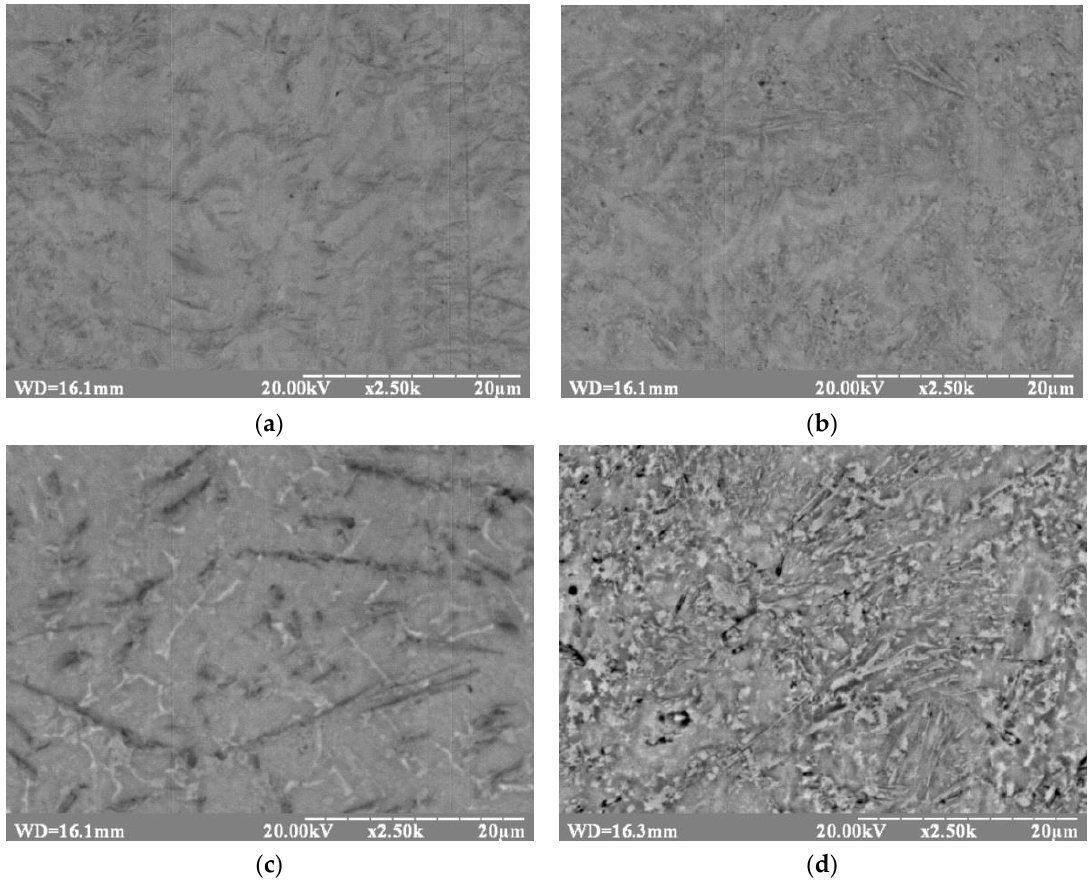
Figure 7. Structure of Ti-TiB alloy in the weld metal after electron-beam welding: ( а ) sample of number 1 series; ( b ) sample of number 2 series; ( c ) sample of number 3 series; ( d ) sample of number 4 series.